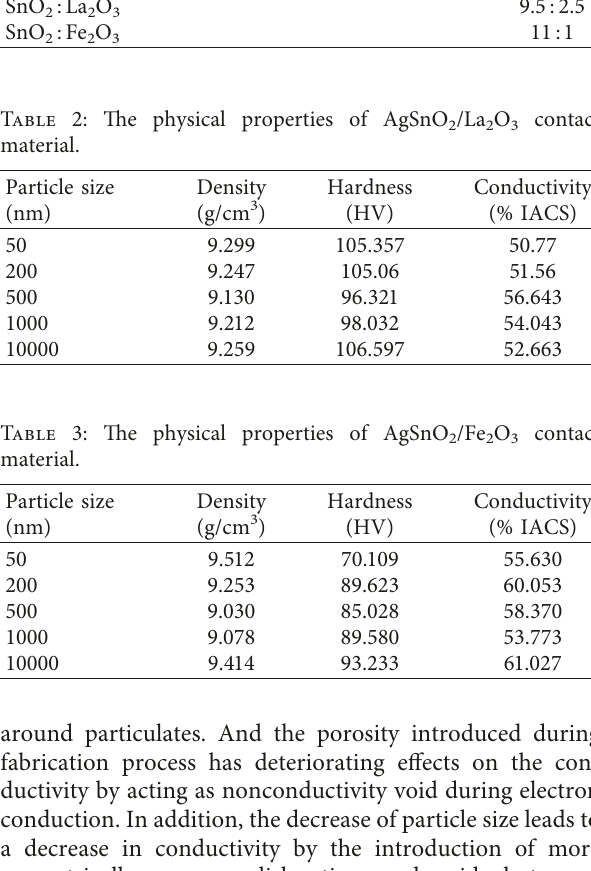
2 contact materials.